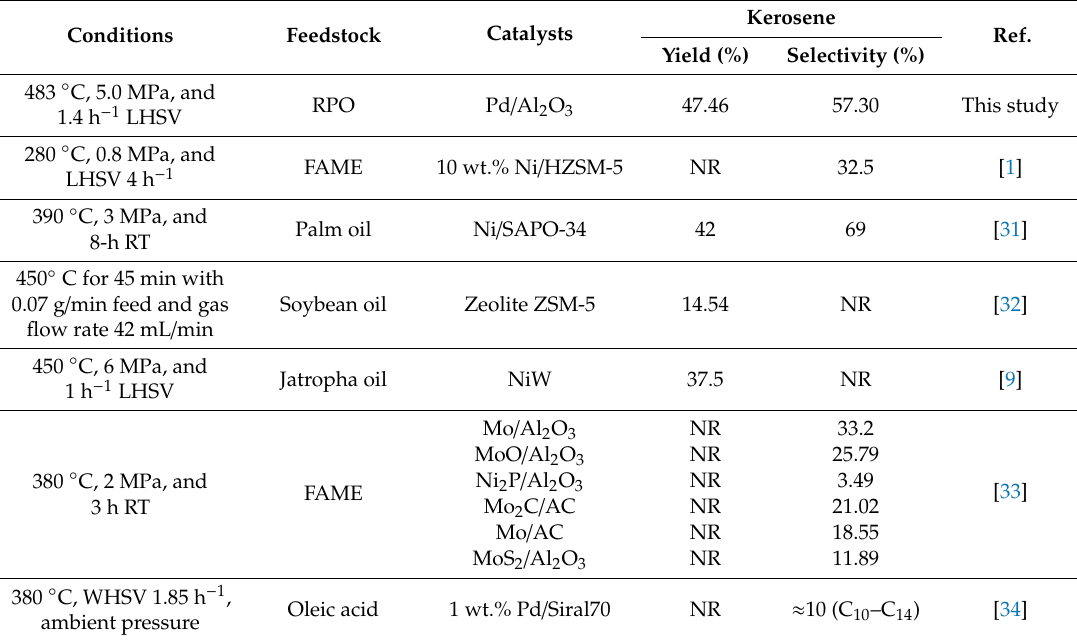
Table 4. Comparative kerosene selectivity and yield from various feedstocks via catalytic cracking process with di ff erent catalysts and operating conditions.